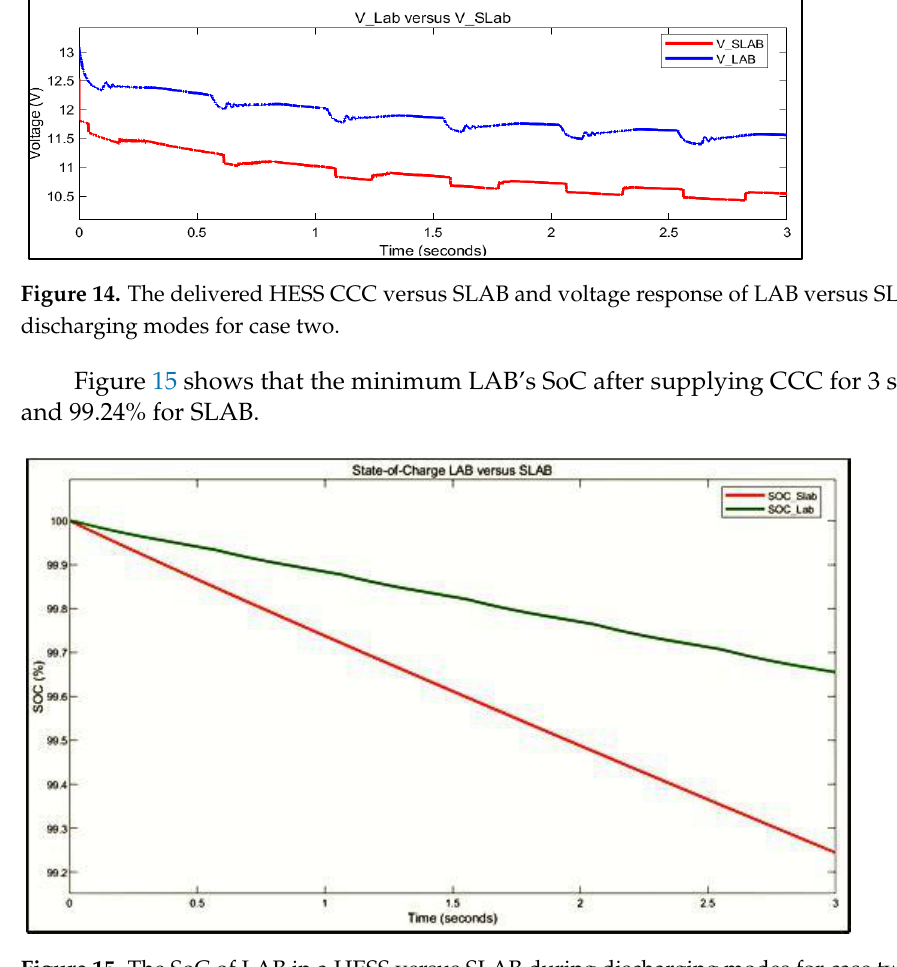
Figure 15. The SoC of LAB in a HESS versus SLAB during discharging modes for case two.